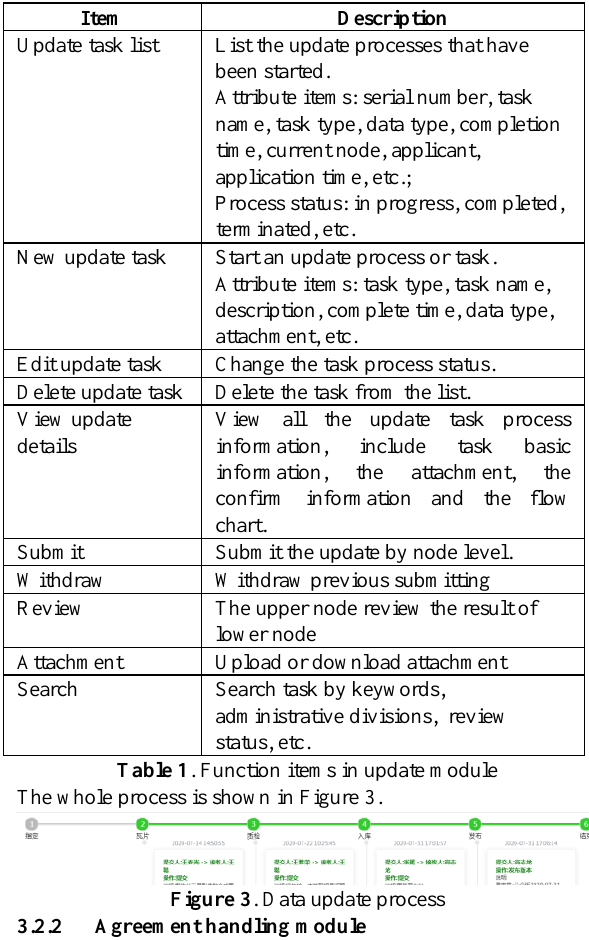
Figure 3 . Data update